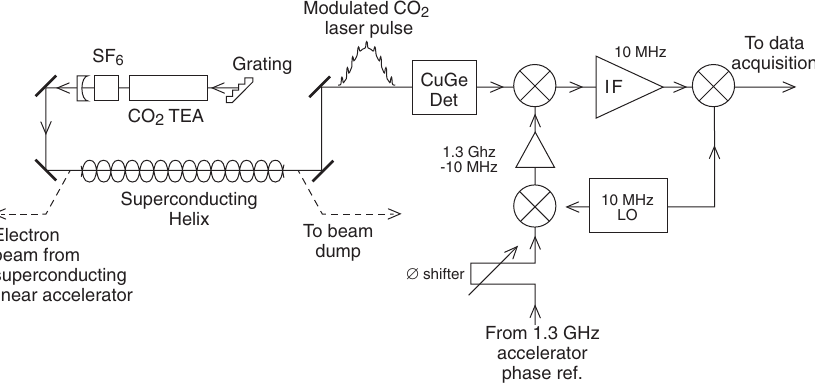
FIG. 4. Schematic drawing showing the setup of the helical undulator magnet, single longitudinal mode CO 2 laser “ master oscillator, ” high speed helium-cooled Cu ∶ Ge detector, and 1.3 GHz phase sensitive detection system used to measure the modulation induced on the 10 . 6 μ m pulses from the master oscillator by their interaction with the 1.3 GHz cw bunched beam from HEPL ’ s pioneering superconducting accelerator.